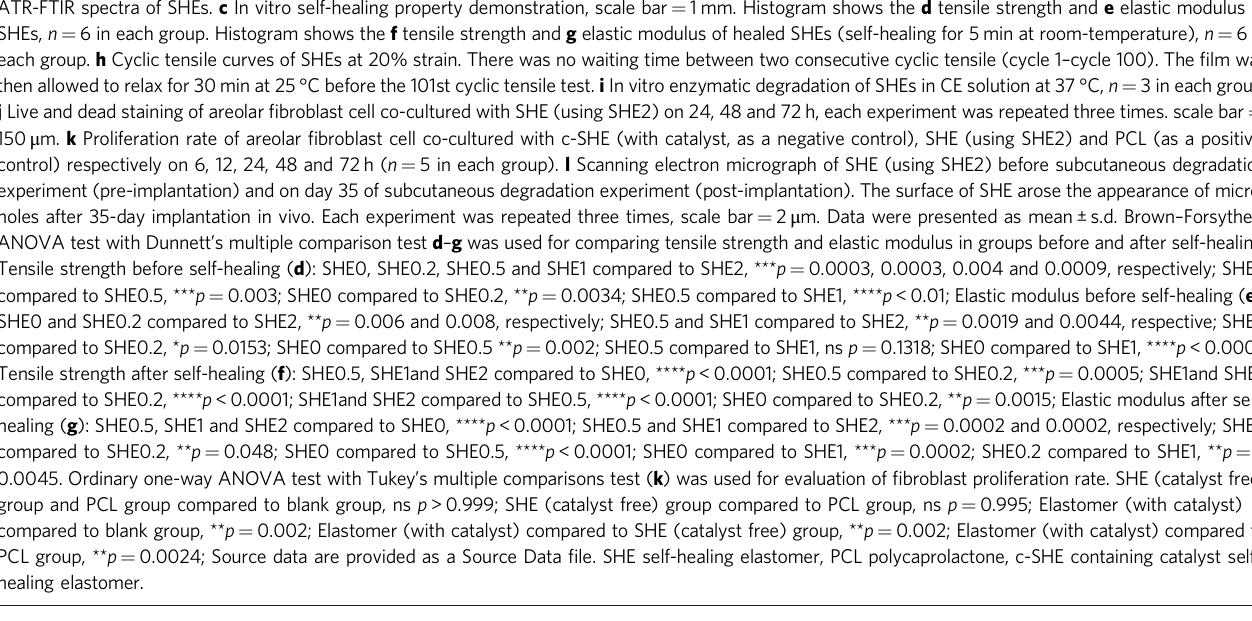
Fig. 2 Pattern diagram of structure of SHEs, mechanical test, ex vivo degradation and biocompatibility analysis. a Molecular structure, schematics and b ATR-FTIR spectra of SHEs. c In vitro self-healing property demonstration, scale bar = 1mm. Histogram shows the d tensile strength and e elastic modulus of SHEs, n = 6 in each group. Histogram shows the f tensile strength and g elastic modulus of healed SHEs (self-healing for 5min at room-temperature), n = 6 in each group. h Cyclic tensile curves of SHEs at 20% strain. There was no waiting time between two consecutive cyclic tensile (cycle 1 – cycle 100). The fi lm was then allowed to relax for 30min at 25°C before the 101st cyclic tensile test. i In vitro enzymatic degradation of SHEs in CE solution at 37°C, n = 3 in each group. j Live and dead staining of areolar fi broblast cell co-cultured with SHE (using SHE2) on 24, 48 and 72h, each experiment was repeated three times. scale bar = 150 μ m. k Proliferation rate of areolar fi broblast cell co-cultured with c-SHE (with catalyst, as a negative control), SHE (using SHE2) and PCL (as a positive control) respectively on 6, 12, 24, 48 and 72h ( n = 5 in each group). l Scanning electron micrograph of SHE (using SHE2) before subcutaneous degradation experiment (pre-implantation) and on day 35 of subcutaneous degradation experiment (post-implantation). The surface of SHE arose the appearance of micro- holes after 35-day implantation in vivo. Each experiment was repeated three times, scale bar = 2 μ m. Data were presented as mean±s.d. Brown – Forsythe ANOVA test with Dunnett ’ s multiple comparison test d – g was used for comparing tensile strength and elastic modulus in groups before and after self-healing. Tensile strength before self-healing ( d ): SHE0, SHE0.2, SHE0.5 and SHE1 compared to SHE2, *** p = 0.0003, 0.0003, 0.004 and 0.0009, respectively; SHE0 compared to SHE0.5, *** p = 0.003; SHE0 compared to SHE0.2, ** p = 0.0034; SHE0.5 compared to SHE1, **** p <0.01; Elastic modulus before self-healing ( e ): SHE0 and SHE0.2 compared to SHE2, ** p = 0.006 and 0.008, respectively; SHE0.5 and SHE1 compared to SHE2, ** p = 0.0019 and 0.0044, respective; SHE0 compared to SHE0.2, * p = 0.0153; SHE0 compared to SHE0.5 ** p = 0.002; SHE0.5 compared to SHE1, ns p = 0.1318; SHE0 compared to SHE1, **** p <0.0001; Tensile strength after self-healing ( f ): SHE0.5, SHE1and SHE2 compared to SHE0, **** p <0.0001; SHE0.5 compared to SHE0.2, *** p = 0.0005; SHE1and SHE2 compared to SHE0.2, **** p <0.0001; SHE1and SHE2 compared to SHE0.5, **** p <0.0001; SHE0 compared to SHE0.2, ** p = 0.0015; Elastic modulus after self- healing ( g ): SHE0.5, SHE1 and SHE2 compared to SHE0, **** p <0.0001; SHE0.5 and SHE1 compared to SHE2, *** p = 0.0002 and 0.0002, respectively; SHE0 compared to SHE0.2, ** p = 0.048; SHE0 compared to SHE0.5, **** p <0.0001; SHE0 compared to SHE1, *** p = 0.0002; SHE0.2 compared to SHE1, ** p = 0.0045. Ordinary one-way ANOVA test with Tukey ’ s multiple comparisons test ( k ) was used for evaluation of fi broblast proliferation rate. SHE (catalyst free) group and PCL group compared to blank group, ns p >0.999; SHE (catalyst free) group compared to PCL group, ns p = 0.995; Elastomer (with catalyst) compared to blank group, ** p = 0.002; Elastomer (with catalyst) compared to SHE (catalyst free) group, ** p = 0.002; Elastomer (with catalyst) compared to PCL group, ** p = 0.0024; Source data are provided as a Source Data fi le. SHE self-healing elastomer, PCL polycaprolactone, c-SHE containing catalyst self- healing